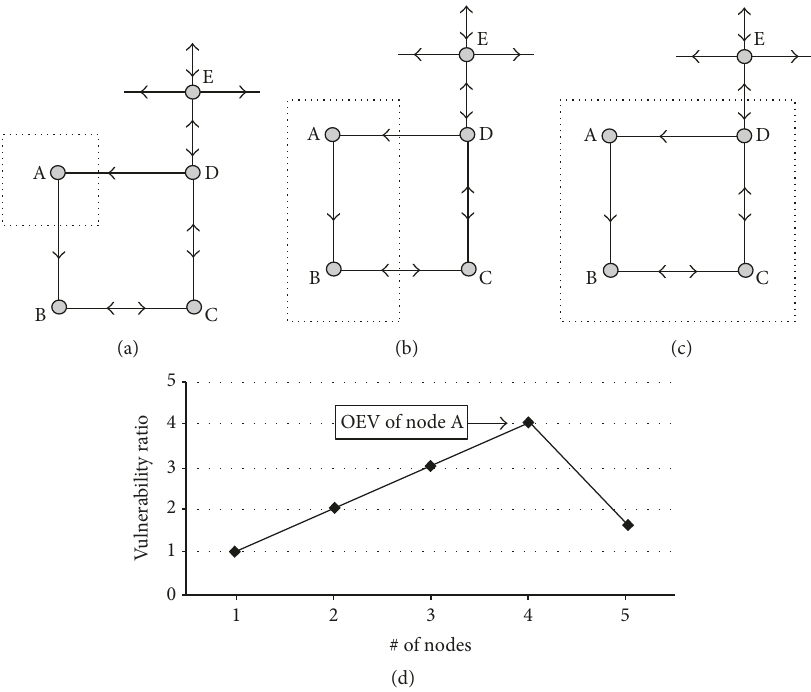
Figure 1: The procedure of searching for the OEV of anchor node A: (a) the search region includes only node A; (b) the search region includes nodes A and B; (c) the search region includes four nodes, where the ratio reaches its maximum and node A’s OEV is derived; (d) the relationship between node A’s outbound vulnerability ratio and the number of nodes in the search